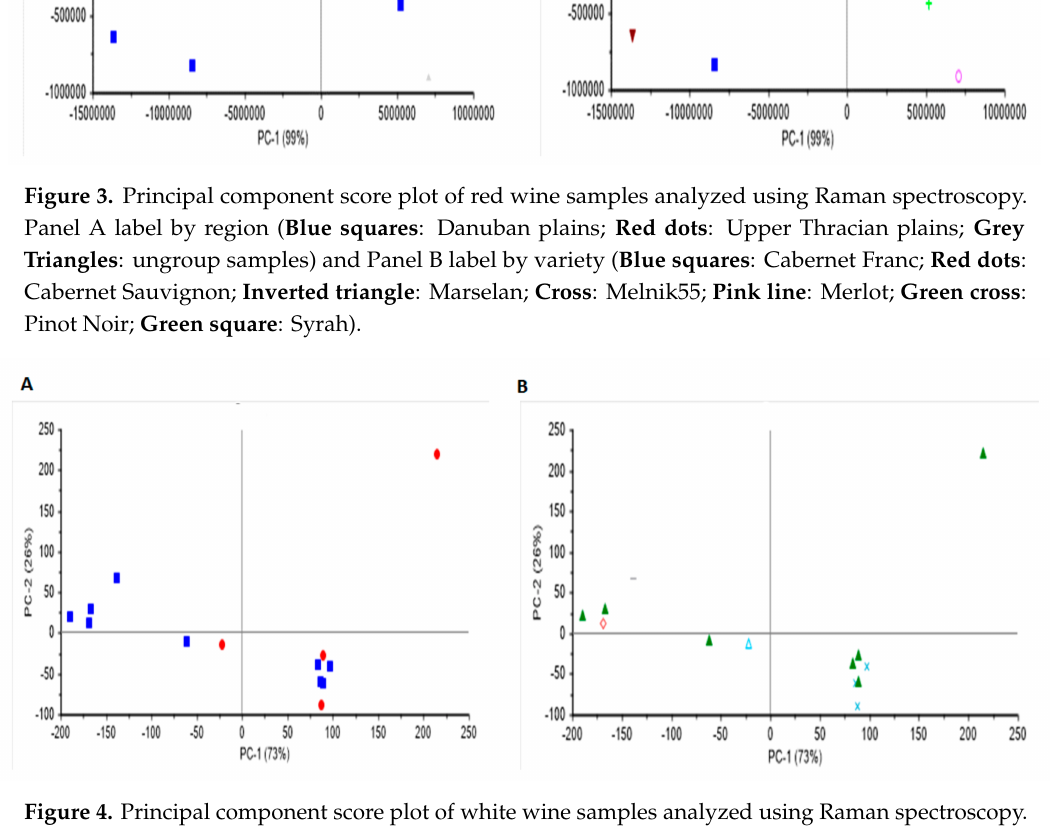
Figure 4. Principal component score plot of white wine samples analyzed using Raman spectroscopy. Panel A label by region ( Blue squares : Danuban plains; Red dots: Upper Thracian plains) and Panel B label by variety ( Green triangle : Chardonnay; Line : Muscat Ottonel; Cross : Sauvignon Blanc; Blue triangle : Tamjanka; Diamond :